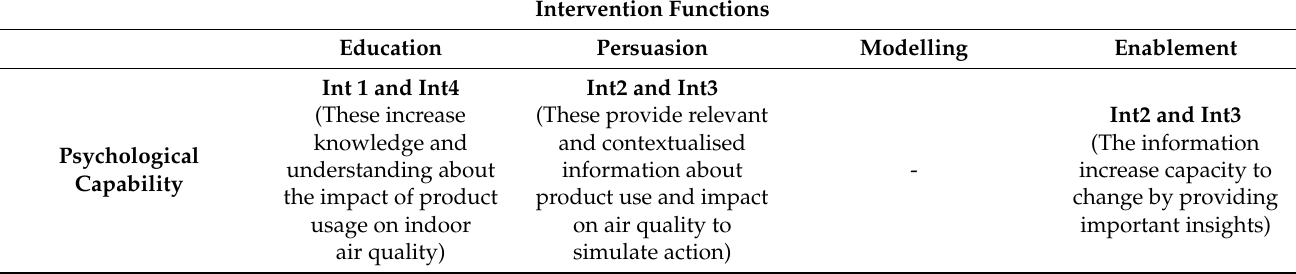
Table 4. COM-B model elements help design interventions for the domestic products that citizens use